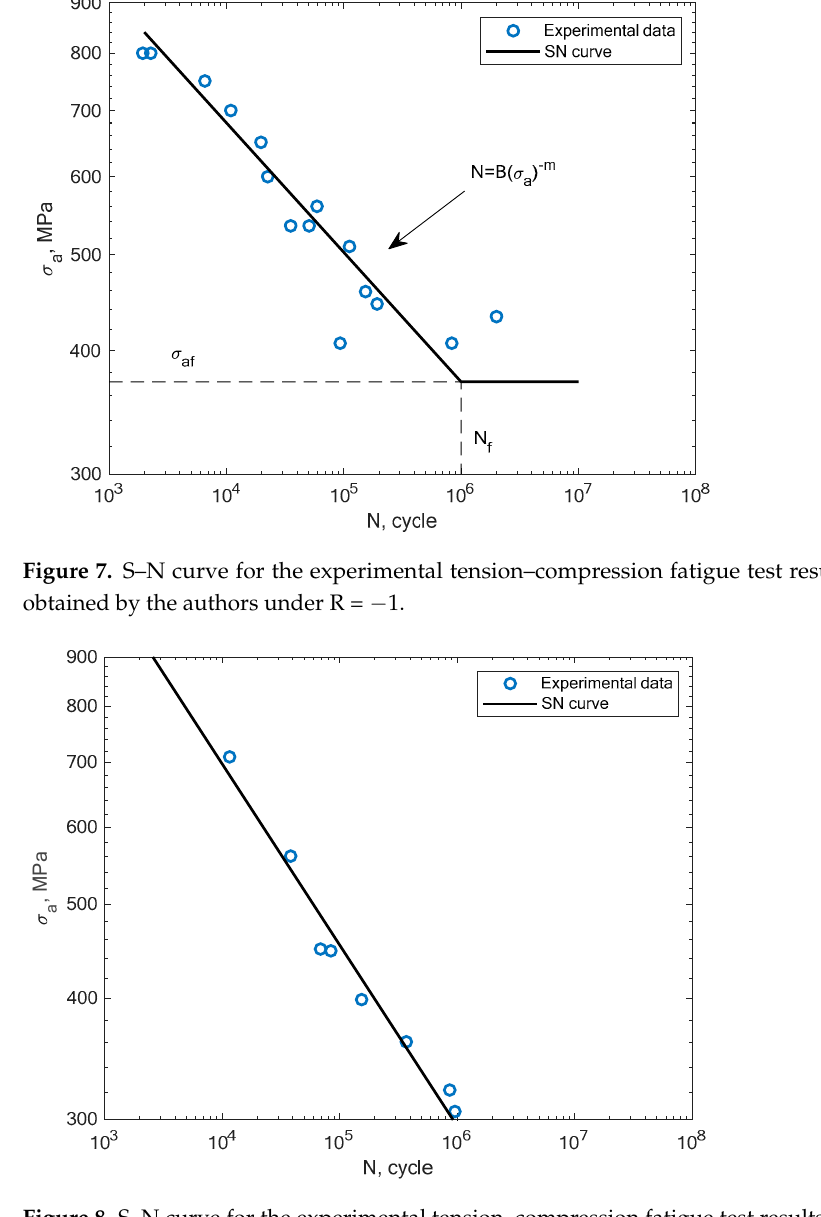
Figure 8. S–N curve for the experimental tension–compression fatigue test results (R = − 1) reported by Branco et al. [14].